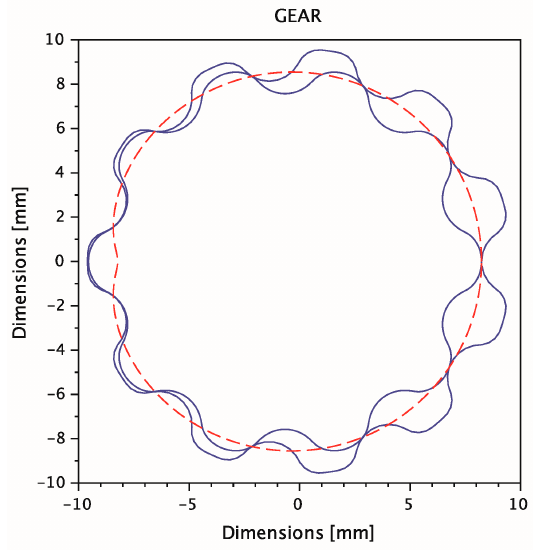
Figure 3. Mini trochoidal-gear profiles and line of contact by using GeroLAB [30].